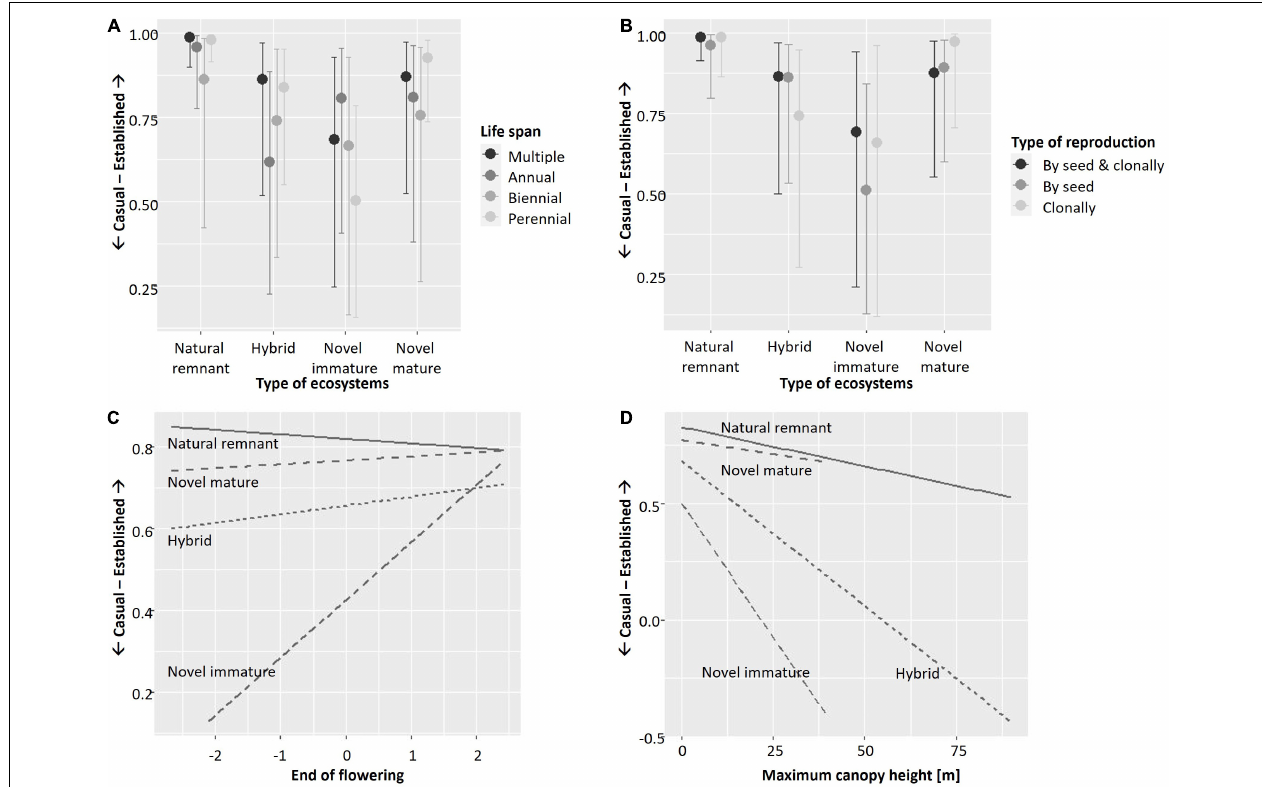
FIGURE 1 | Plots illustrating significant interactions of (A) life span, (B) type of reproduction, (C) end of flowering, and (D) maximum canopy height with type of ecosystem in explaining the establishment of vascular plant species in Berlin, Germany. Results shown are based on the full model (cf. Table 3 ). Y-axes show casual vs. established species as an ordinal response variable; for (A,B) x-axes show the four types of ecosystems, while for (C,D) , x-axes show the respective trait. (A,B) Were created using function “conditional_effects.brmsfit” in R-package brms (Bürkner, 2017). (C,D) Were created using function “ggplot” in R-package ggplot2 with geometric smoother (Wickham, 2016).